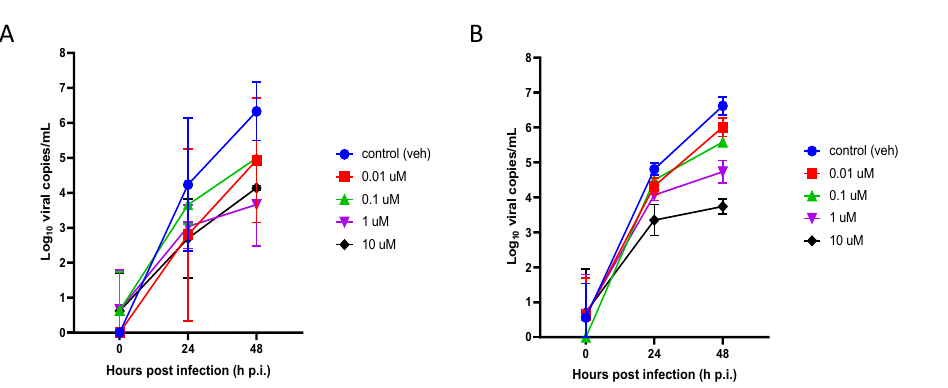
Figure 6. Infection Kinetics of IAV-inoculated PREDICT96-ALI Airway Tissue in Response to Oseltamivir. RT-qPCR analyses for viral copies of the apical wash of PREDICT96-ALI airway tissue at 24 and 48 h p.i. in absence (blue, vehicle control) or presence (red = 0.01 µM, green = 0.1 µM, violet = 1 µM, black = 10 µM) of oseltamivir (Tamiflu) for two donors labeled donor B ( A ) and donor C ( B ). PREDICT96-ALI airway tissue inoculated with A/Hong Kong/8/68 H3N2 at MOI = 0.1, and monitored for viral load over 24 h intervals up to 48 h p.i. with a marked decrease in viral copies in response to oseltamivir dose at both time points. N = 2 independent experiments with data presented from one representative experiment. Per experiment, N = 3–4 tissue replicates per donor, time-point and condition. Replicates that did not meet the minimum signal intensity after 45 PCR cycles are displayed along the